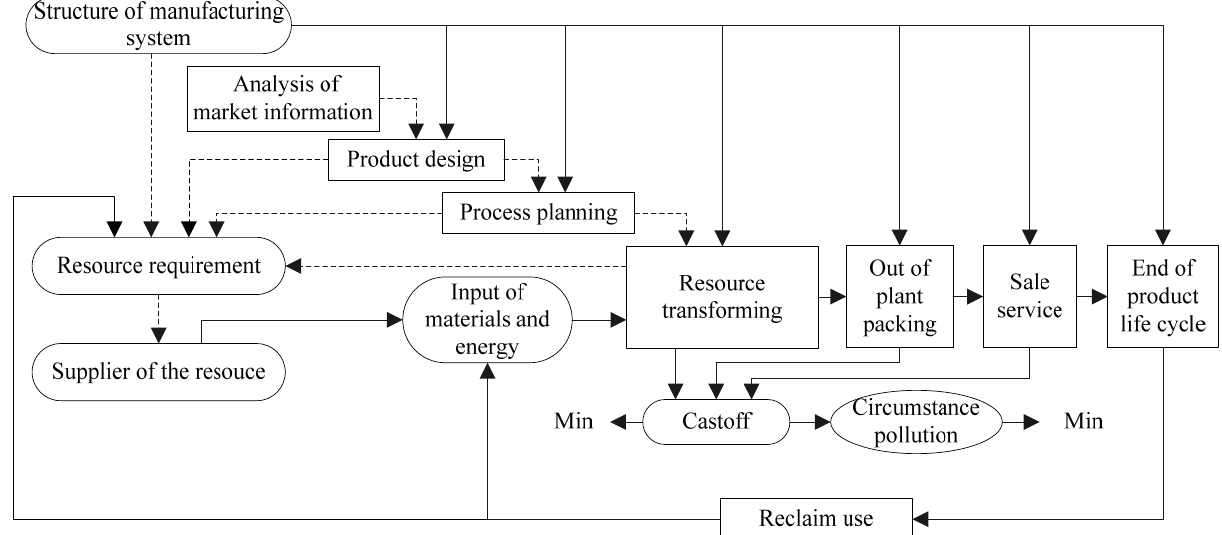
Figure 2. Resource flow model in terms of